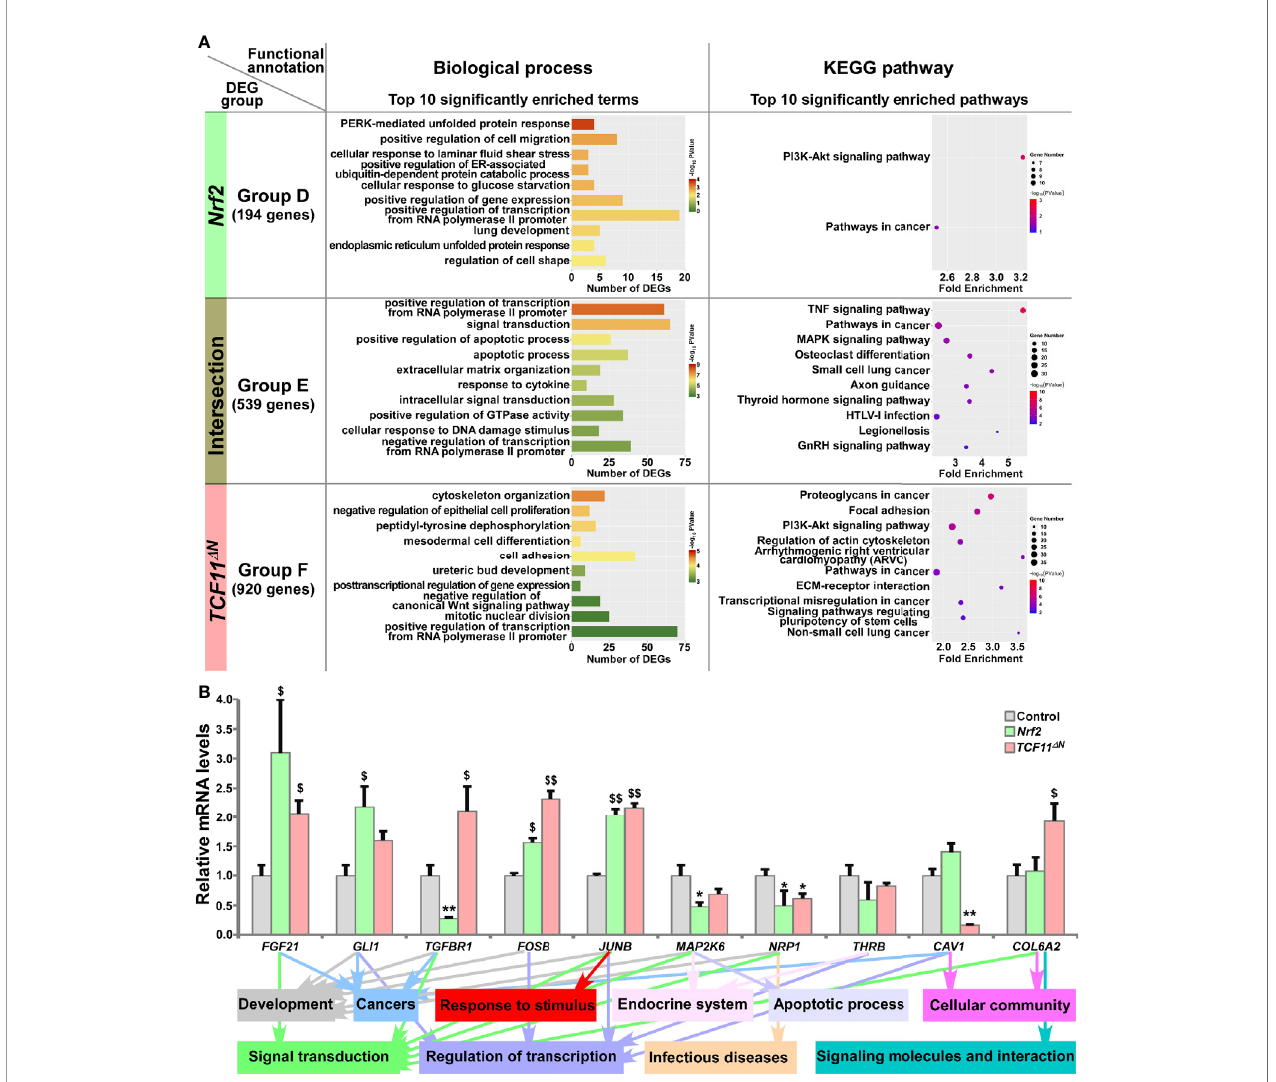
FIGURE 4 | Functional annotation of speci fi c or common DEGs in Nrf2 and TCF11 D N cells. (A) Top 10 of signi fi cant biological process terms and pathways enriched by DEGs in Groups D, E, and F were exhibited in histograms and scatterplots, respectively. (B) After induced with 1 m g/ml Tet for 12 h, total RNAs were isolated from Nrf2 , TCF11 D N or Control cell lines and then reversely transcribed into the fi rst strand of cDNA. Subsequently, the mRNA levels of DEGs that were associated with more functions as annotated, along with high expression levels and well signi fi cance in Groups D to F, were determined by quantitative real-time PCR analysis of Nrf2 , TCF11 D N and Control cells. The data are shown as mean ± SEM (n = 3 × 3, * p < 0.05; ** p < 0.01; $ p < 0.05; $$ p < 0.01, when compared to the Control values